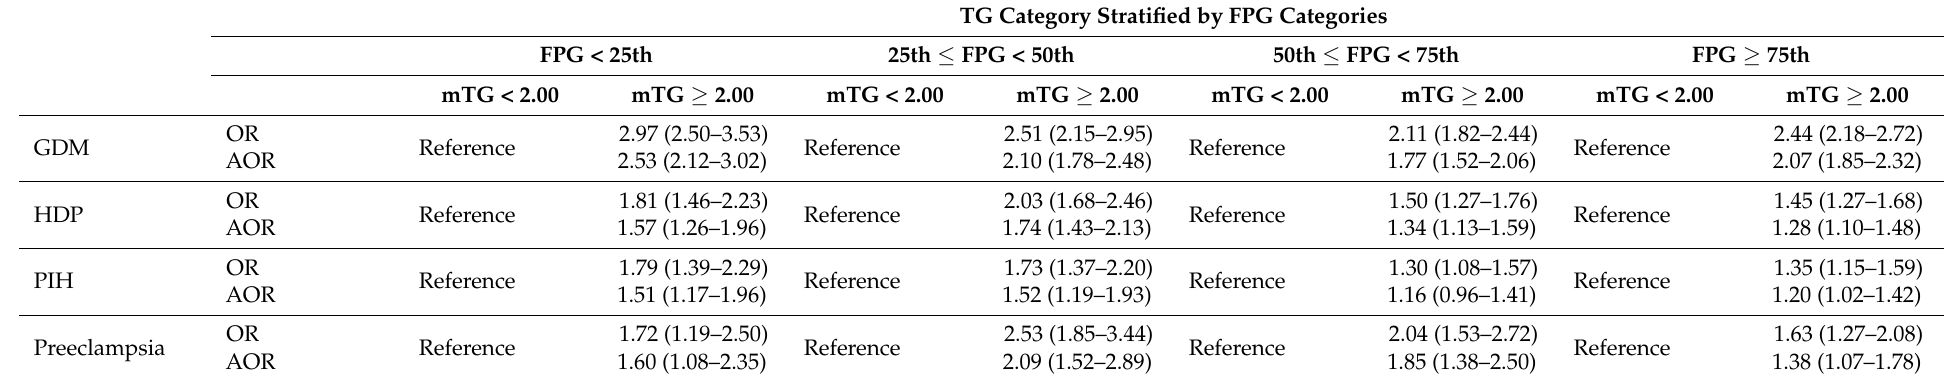
Table 3. Associations between mTG in early pregnancy and pregnancy complications stratified by maternal FPG in early pregnancy. TG Category Stratified by FPG